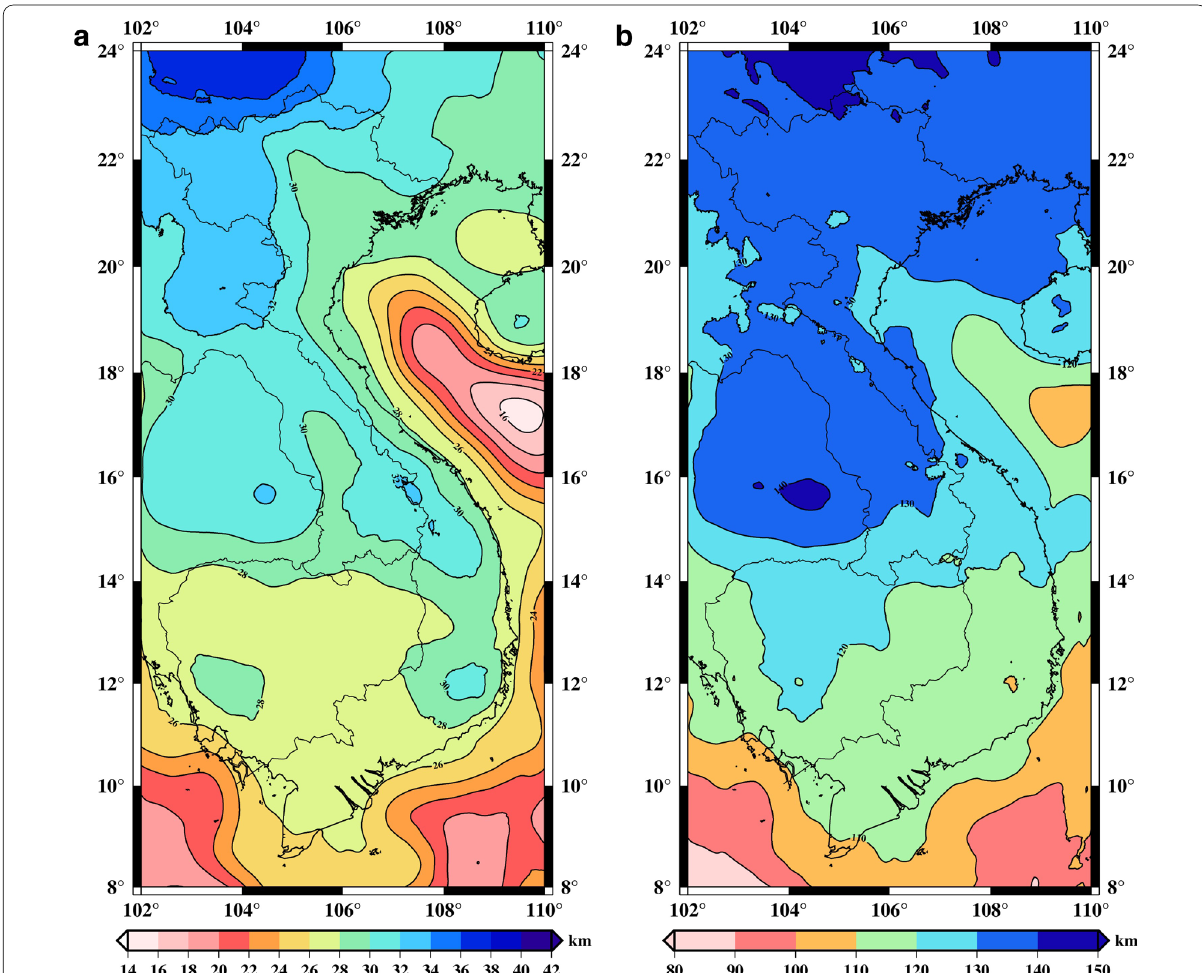
Fig. 9 Lithospheric structure derived from elevation and geoid height data. a Depth of Moho (Moho_GEOID) and b depth of the lithosphere